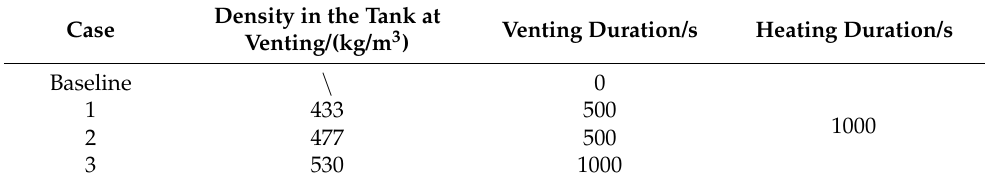
Table 10. Parameters of different cases in phase